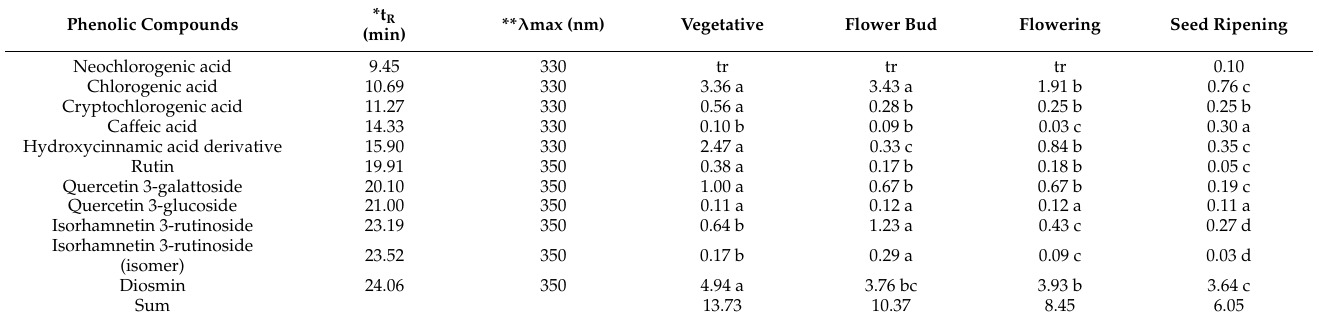
Table 7. HPLC analysis of individual phenolic compounds (mg g − 1 DM) in Sulla coronaria